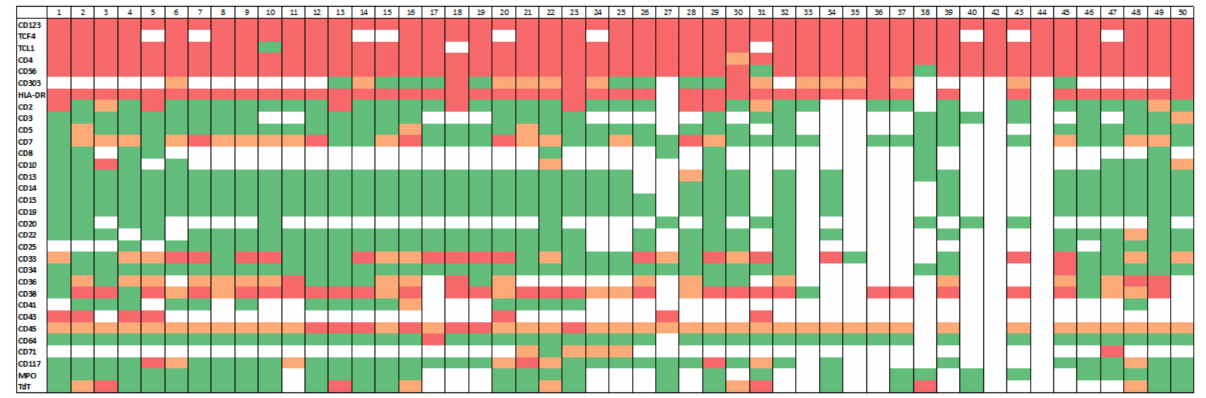
Figure 1. Immunophenotypic landscape of blastic plasmacytoid dendritic cell